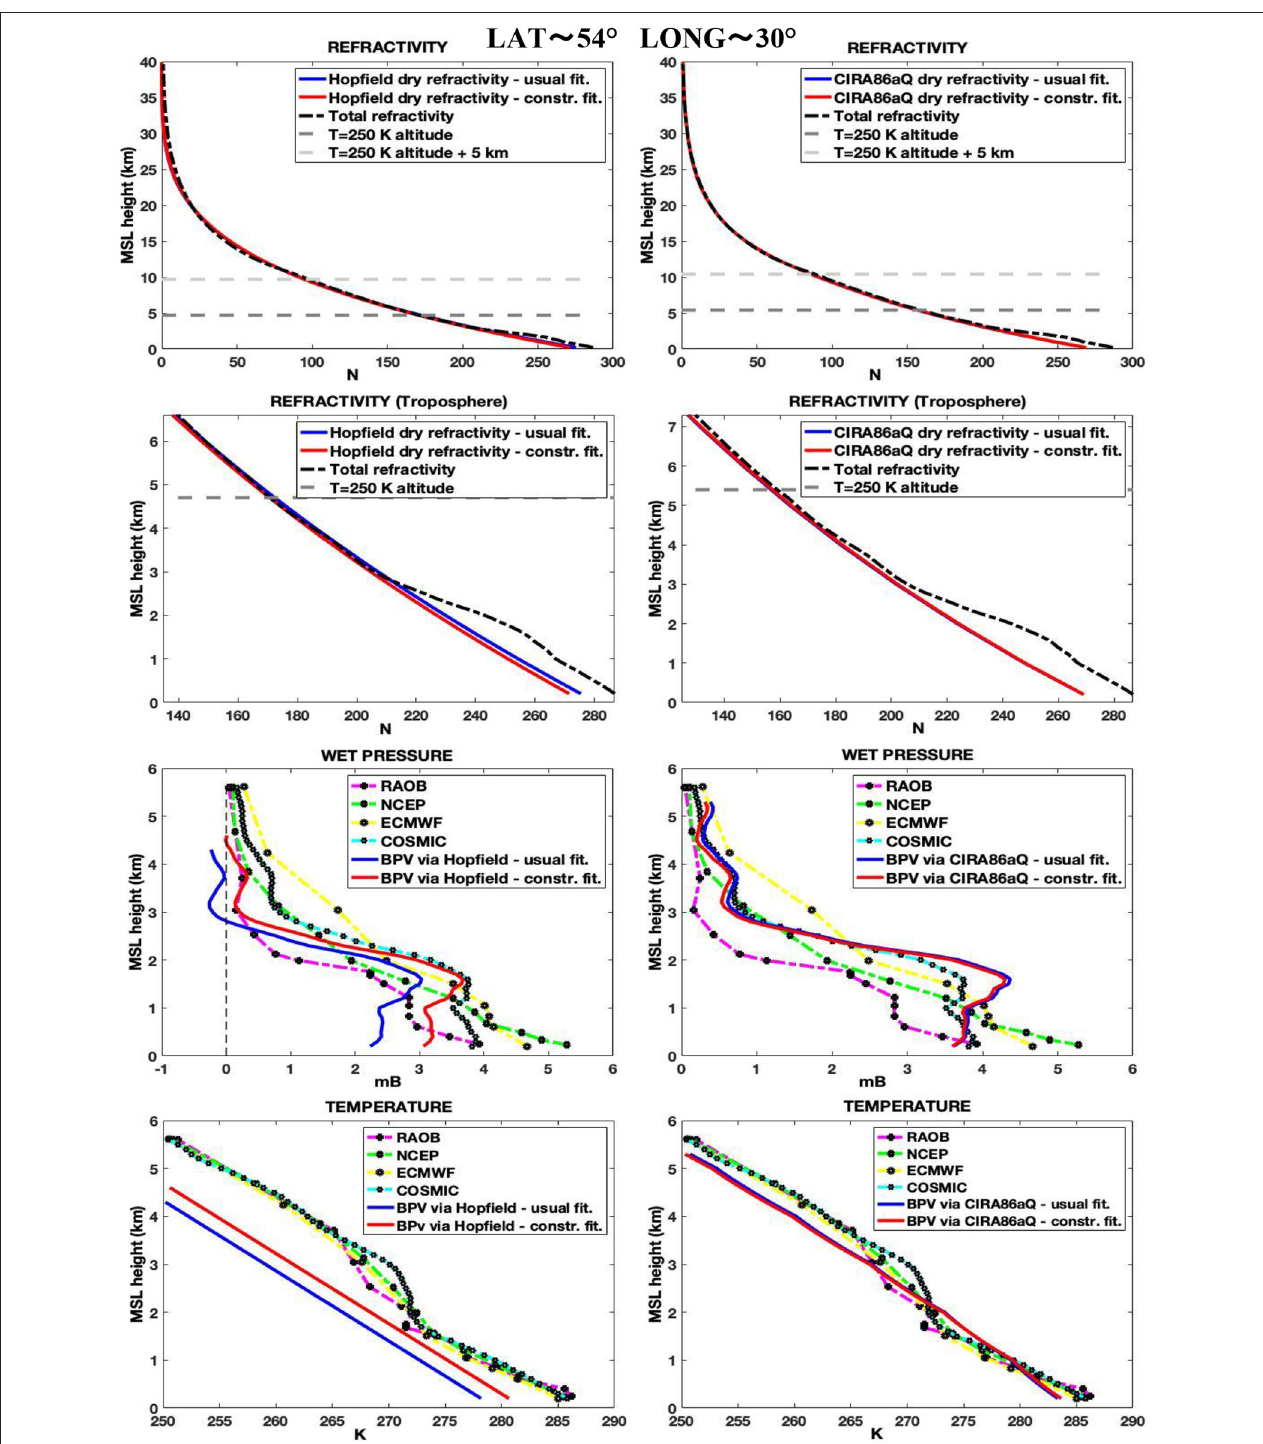
FIGURE 5 | Profiles of the same quantities of the previous figure, for a middle latitude location. About the wet pressure with the Hopfield model, we observe that the unphysical behavior for the profile recovered by the previous BPV method is corrected with the second constrained fitting.